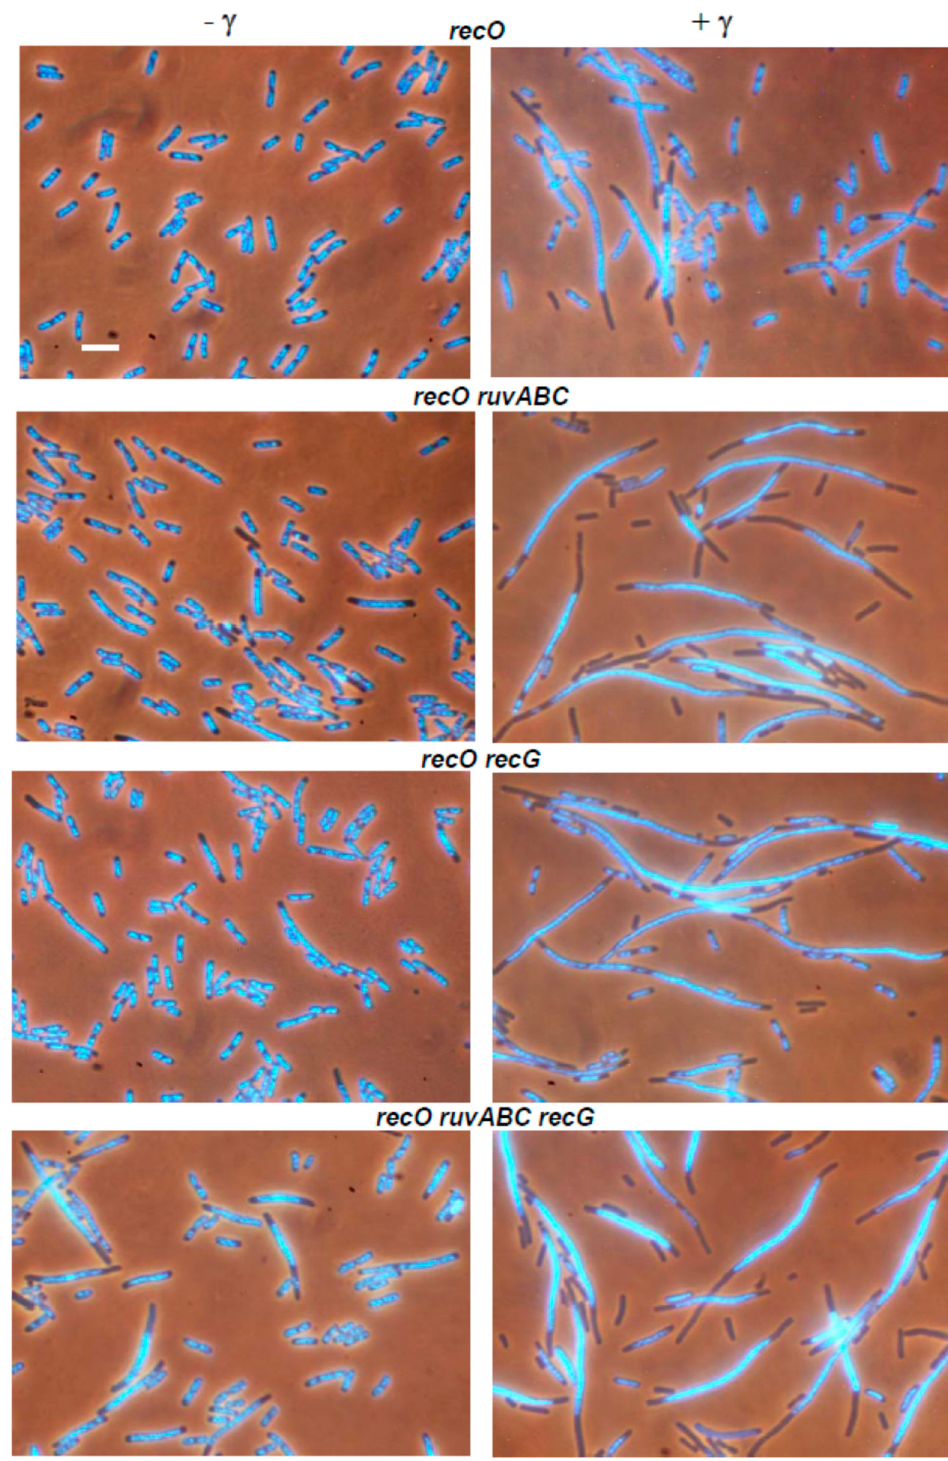
Figure 8. The recO mutation does not suppress γ -radiation-induced cytological defects in ruvABC and/or recG mutants. Bar, 5 μ m.